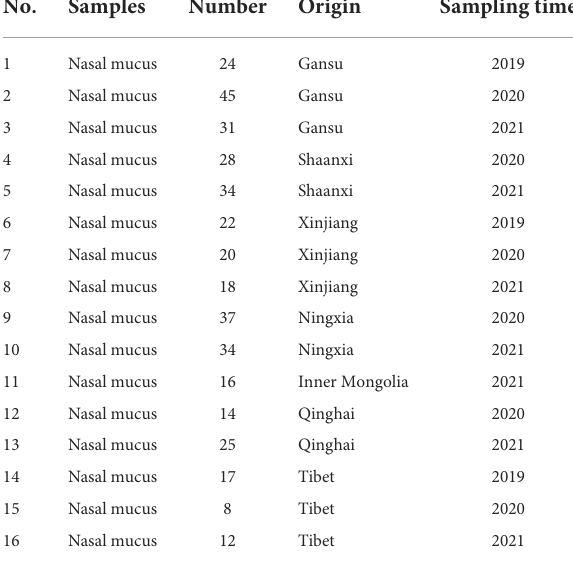
TABLE 1 The collection of nasal